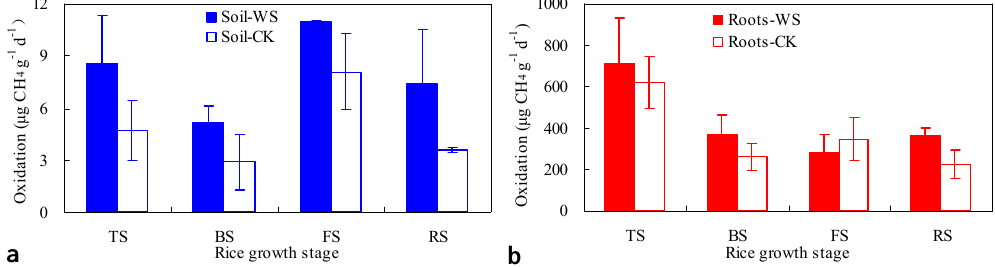
Fig. 4. Potential CH 4 oxidation rates in aerobically incubated paddy soil (a) and rice roots (b) at the four rice growth stages. TS: tillering stage, BS: booting stage, FS: grain-filling stage, RS: ripening stage. WS: straw incorporation, CK: without straw incorporation. Mean ± SD, n =